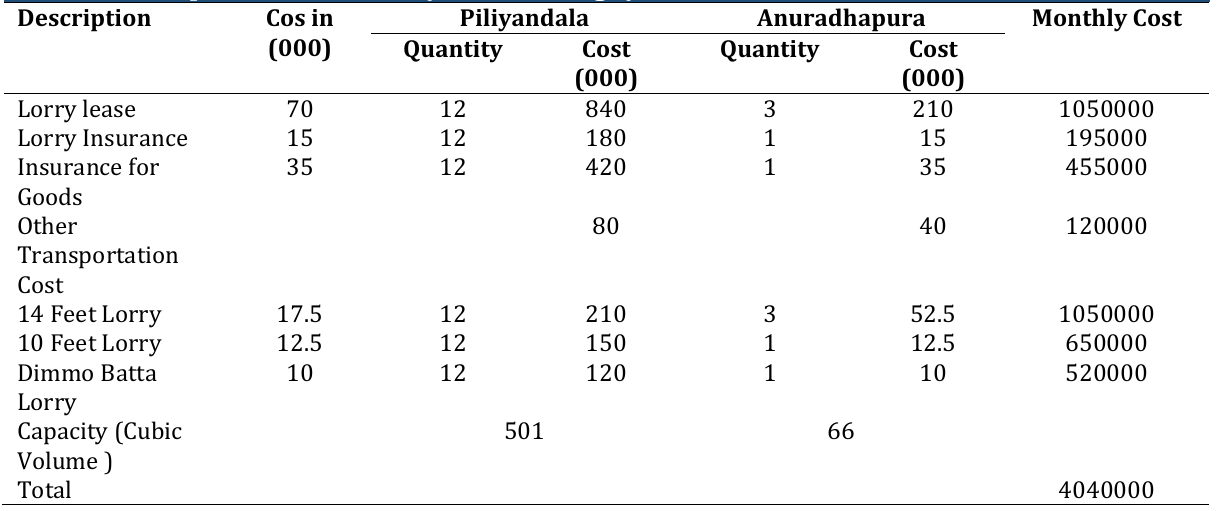
Table 4: Transportation cost analysis on exiting system